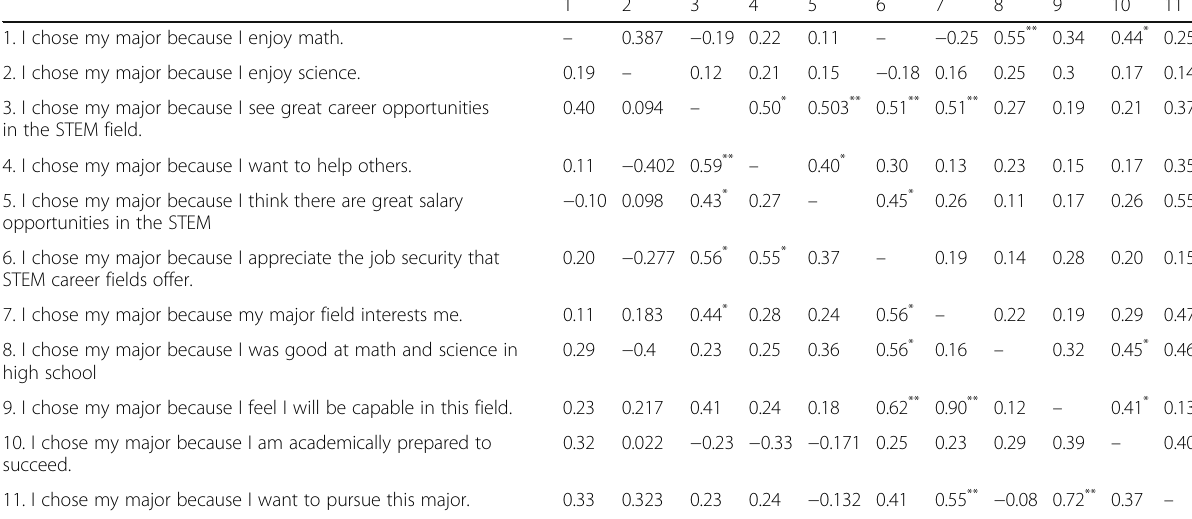
Table 8 Correlations for responses to “ Why did you choose your major?